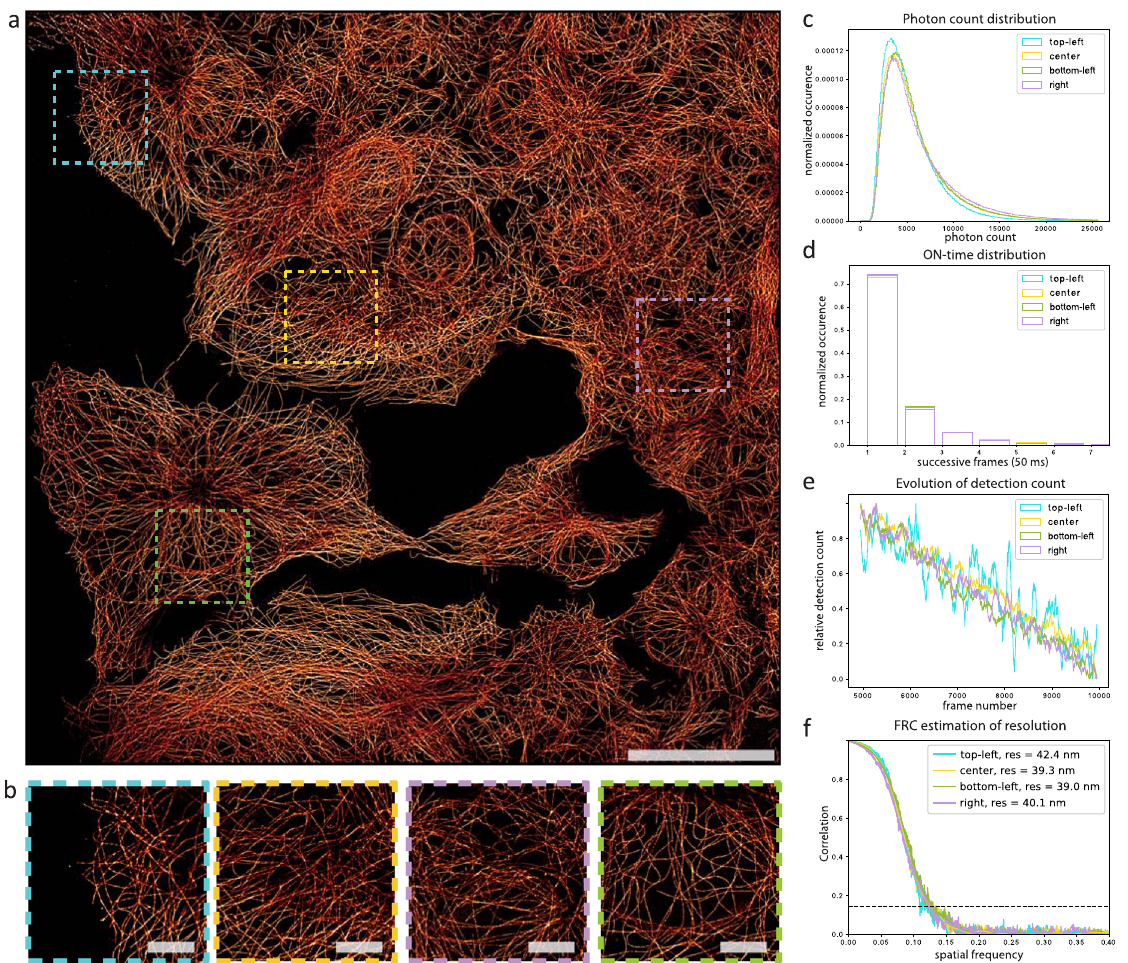
Fig. 4 STORM imaging using ASTER. a ASTER STORM imaging of COS-7 cells labeled for microtubules and an AF647-coupled secondary antibody, FOV size 200 µ m × 200 µ m, 20,000 frames at 20 fps. Excitation consisted in a ten-line scan with a laser power of 250 mW at the BFP, a gap of 1.4 σ and a 25 ms scanning period. Scalebar 50 µ m. b Zoomed views of highlighted areas in a . Scalebars 10 µ m. c Photon count distribution histogram for highlighted areas in a . d Blinking ON-time distribution for highlighted areas in a , expressed in number of successive frames (50 ms camera integration time). e Temporal evolution of detection count for highlighted areas in a . f FRC estimation of resolution for highlighted areas in a